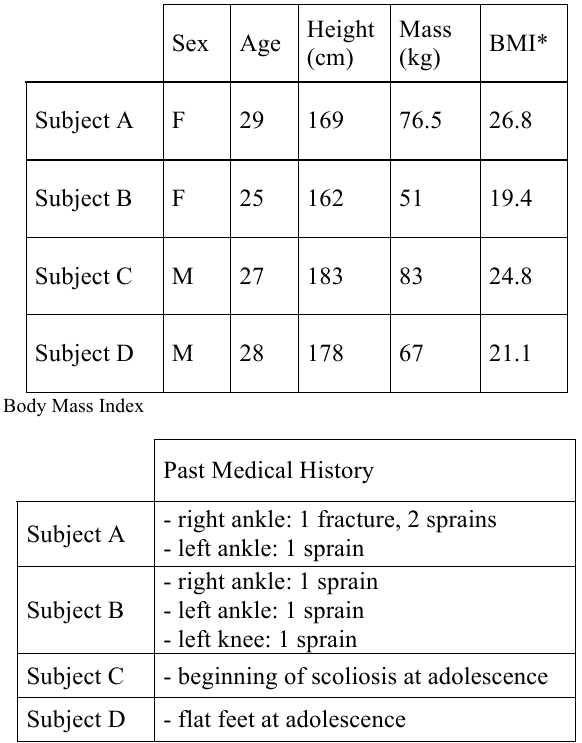
Table 1. Characteristics of the four subjects